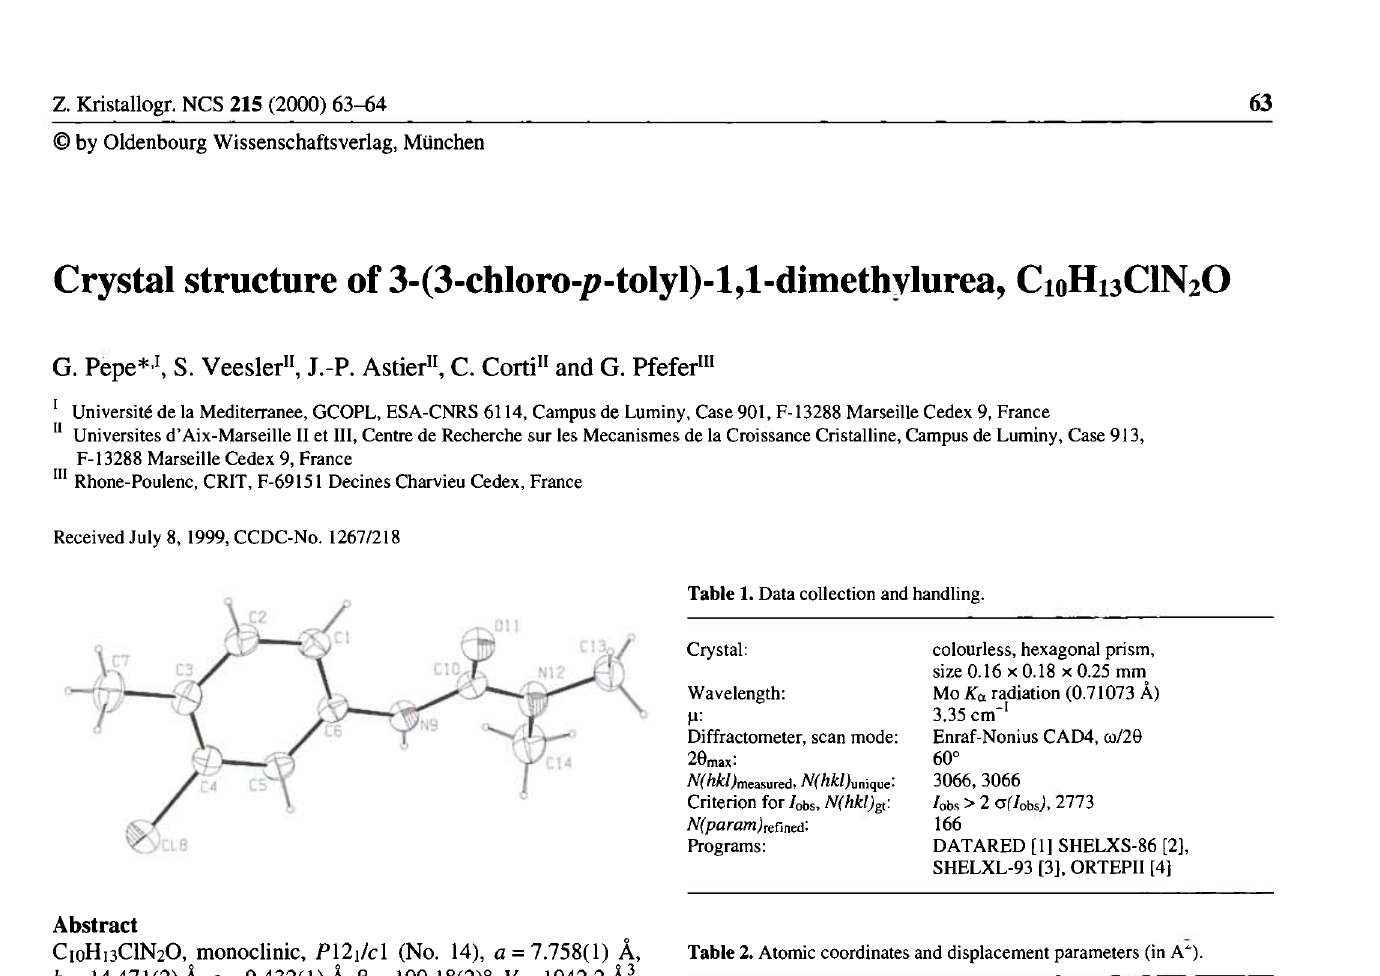
Table 2. Atomic coordinates and displacement parameters (in A ).